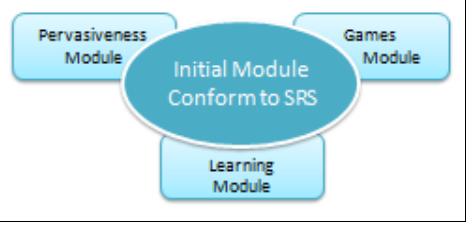
Figure 3. The proposed modules for the ontology of